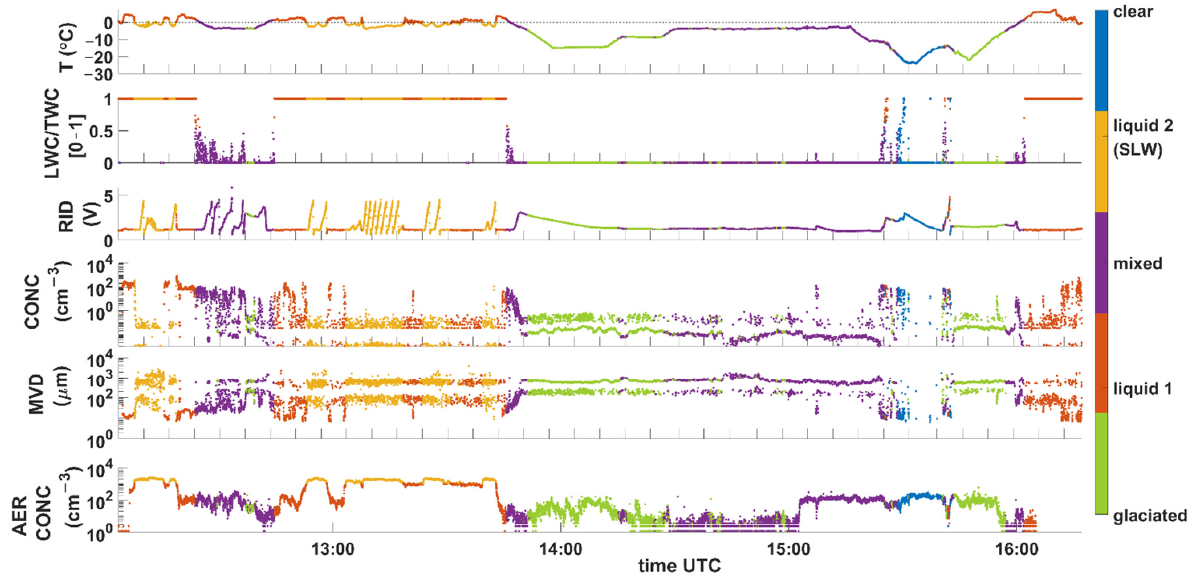
Figure 8. Time series plots of in situ measurements collected in flight F20 on 23 February 2019. Color coding denotes different clusters assigned by k-means algorithm. From Top to Bottom, the panels illustrate probe measurement from the temperature sensor, LWC/TWC ratio, RID, combined FSSP and OAP concentration and MVD, and aerosol number concentration. Due to the 1 Hz temporal averaging cloud particle concentration and size often appear as bimodal on the fulltime scale of the flight.